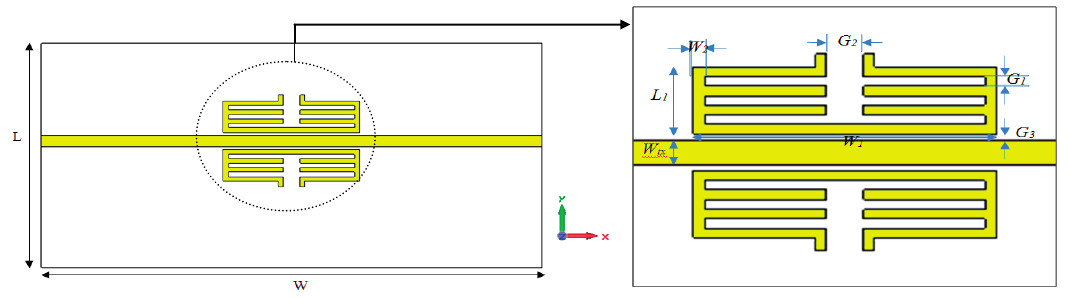
Figure 2. Schematic view of the centered-gap MSRR Structure and its